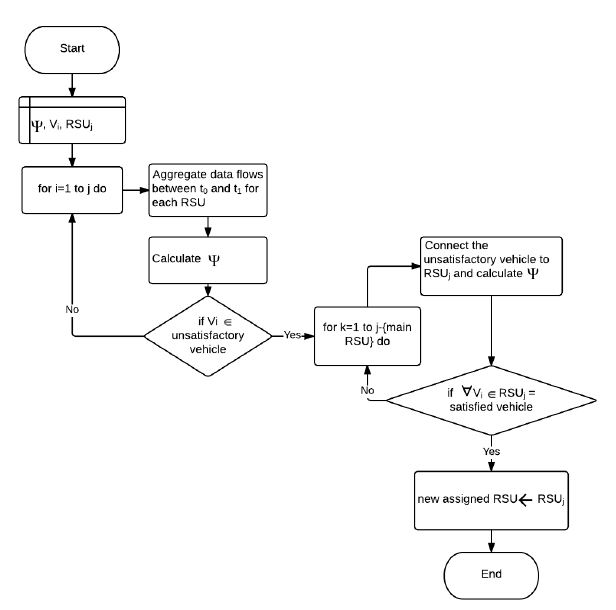
Figure 4. Flowchart of Flow Management